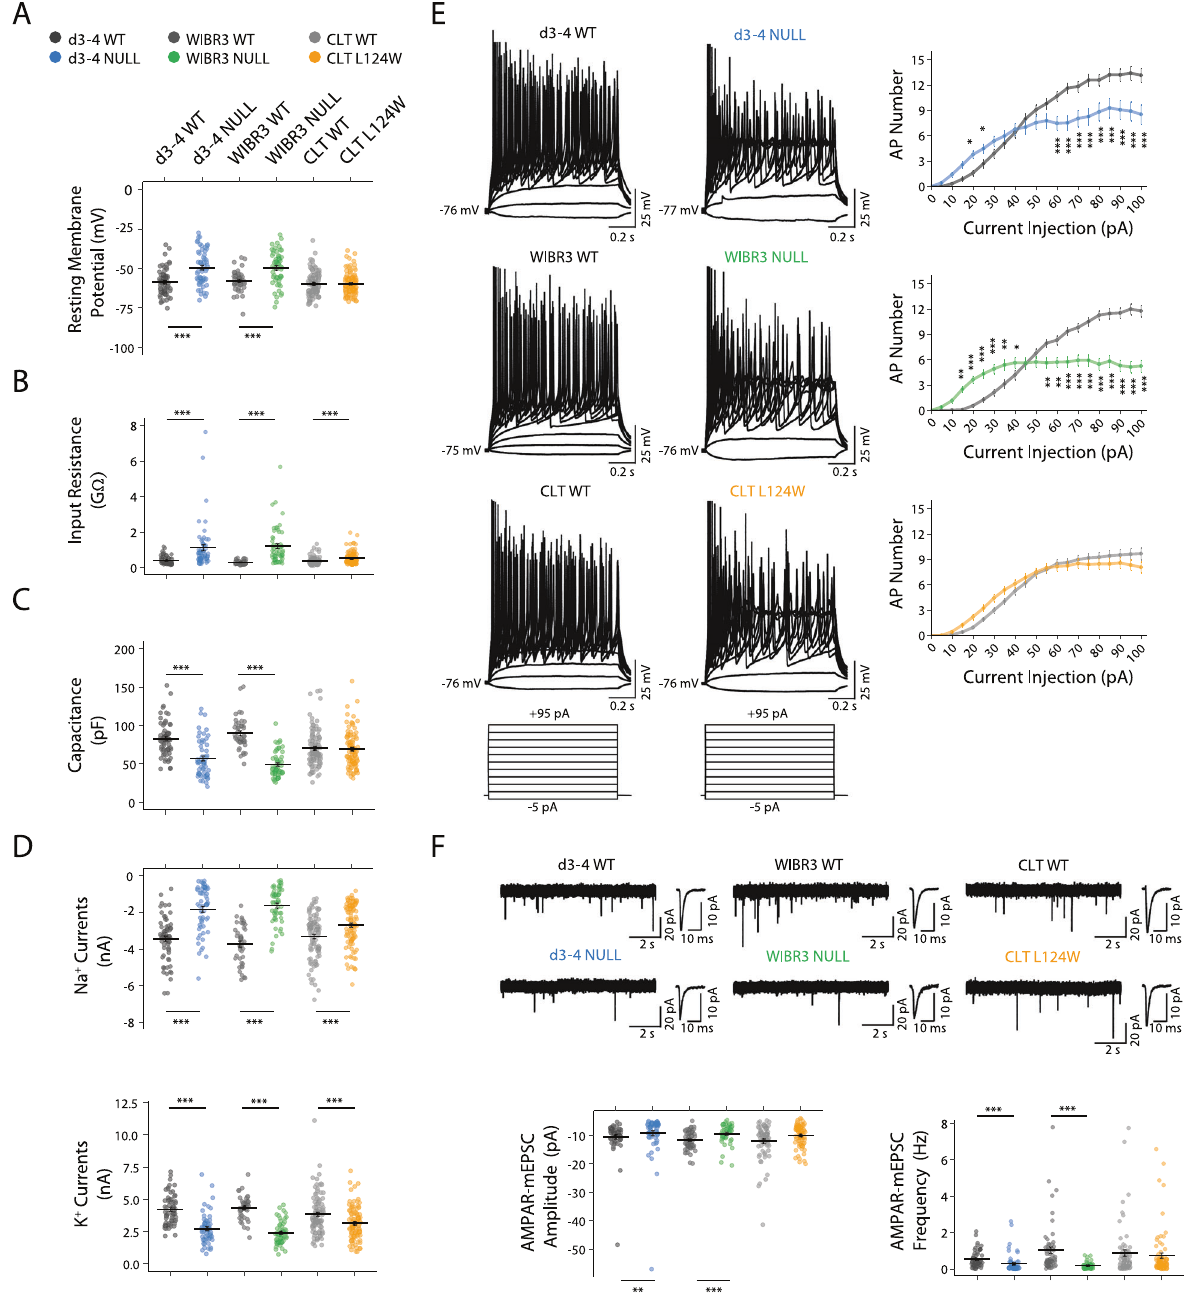
Fig. 2 De fi cits in intrinsic membrane properties and excitatory synaptic function in RTT neurons. A – D Scatter plots showing all data points for the resting membrane potentials ( A ), input resistance ( B ), cell capacitance ( C ), voltage-gated Na + currents measured at − 10 mV ( D , Top), and voltage-gated K + currents measured at + 60 mV ( D , Bottom) in 4 – 5 week-old Ngn2 neurons of WT ( n = 66, 42, and 99, respectively) and RTT from d3-4 ( n = 58), WIBR3 ( n = 55), CLT ( n = 100). The graphs also display average resting membrane potentials, input resistance, cell capacitance, Na + currents and K + currents. E Left, Representative traces showing evoked action potentials in 4 – 5 week-old Ngn2 neurons of WT and RTT from d3-4, WIBR3 and CLT. Right, Plots depict the numbers of evoked action potentials triggered by a series of current steps from + 5 pA to + 100 pA for 1 s in 4 – 5 week-old Ngn2 neurons of WT ( n = 66, 42, and 99, respectively) and RTT from d3-4 ( n = 58), WIBR3 ( n = 55), CLT ( n = 100). F Top, Typical traces display mEPSCs in 6 weeks old Ngn2 neurons of WT and RTT from d3-4, WIBR3 and CLT. Inset shows averaged mEPSCs in the neuron on the left. Bottom, Scatter plots display all data points for the amplitude and frequency of mEPSCs. The graphs also display average amplitude and frequency of mEPSCs in 6 weeks old Ngn2 neurons of WT ( n = 56, 58, and 68, respectively) and RTT from d3-4 ( n = 62), WIBR3 ( n = 44) and CLT ( n = 78). All data were shown as mean + / − SEM. 2 lines of isogenic WT and 2 lines of CLT L124W data were pooled. Statistical signi fi cance was evaluated by Student ’ s t -test or Mann – Whitney test, as appropriate, in Panel ( A – D and F ), and by two-way repeated measure ANOVA followed by post hoc test in Panel ( E ). * p < 0.05, ** p < 0.01, *** p < 0.001.